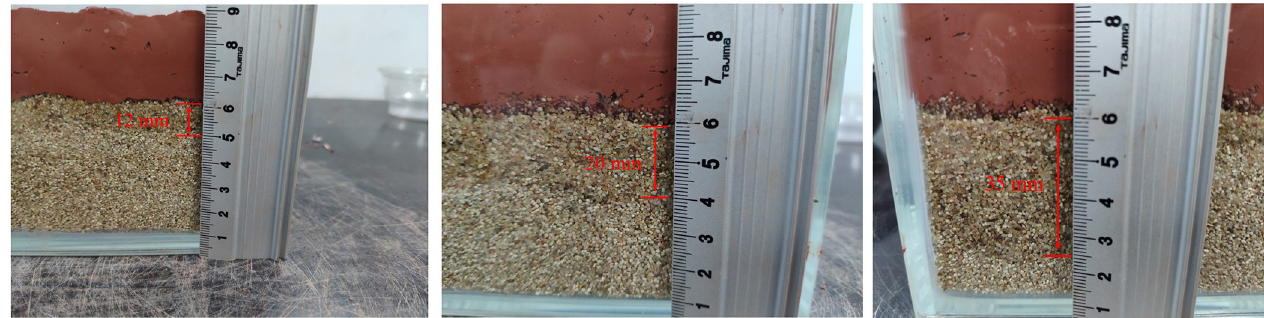
Fig 16. Infiltration of 32 mm thick naturally weathered red-bed soil films after dropping 1 mol/L HCl (A) 1 mol/L HCl dropped on a 32 mm thick naturally weathered red-bed soil film for 3 min; (B) 1 mol/L HCl dropped on a 32 mm thick naturally weathered red-bed soil film for 6 min; (C) 1 mol/L HCl dropped on a 32 mm thick naturally weathered red-bed soil film for 9 min.